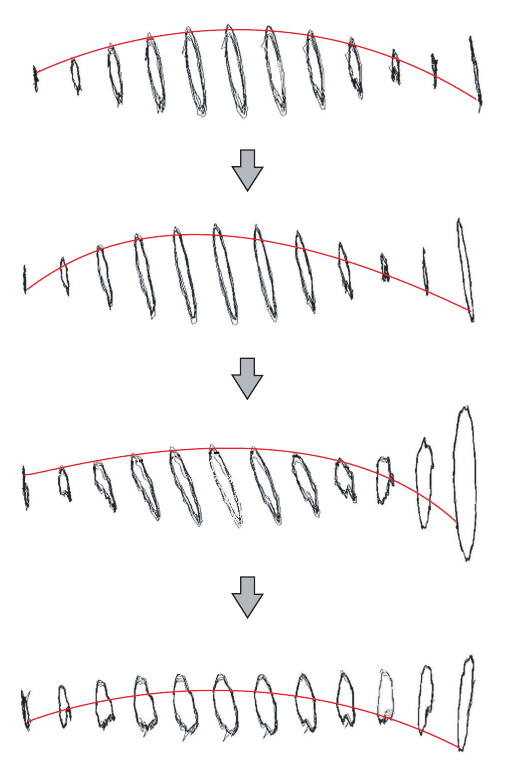
Figure 7: Orbital evolution of the flexible rotor passing through the first backward critical speed.